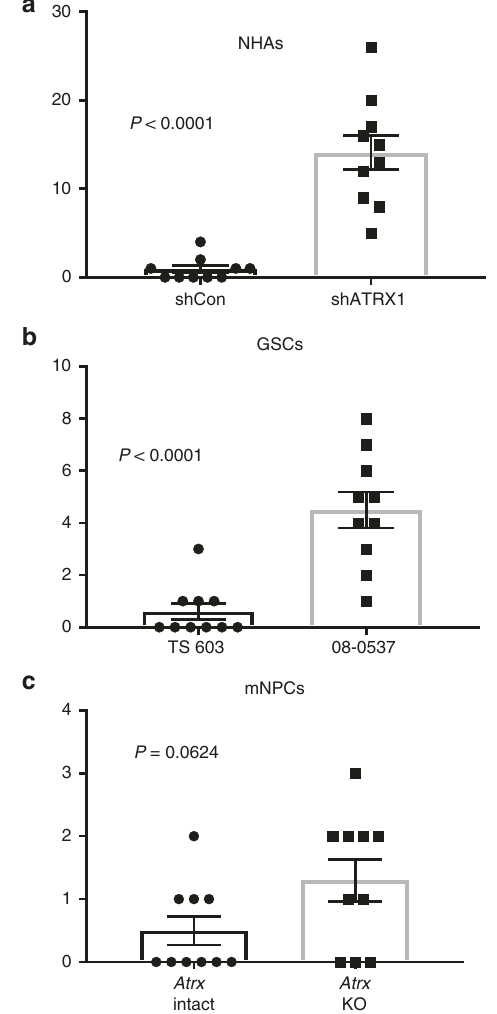
Fig. 3 ATRX de fi ciency induces chromosome breaks. a ATRX-de fi cient NHAs (shATRX1, passage 15) showed signi fi cantly increased chromosome breaks by cytogenetic analysis relative to ATRX-intact controls (shCon). b ATRX -mutant GSCs (08-0537) showed signi fi cantly increased chromosome breaks by cytogenetic analysis relative to ATRX wild-type GSCs (TS 603). c Quanti fi ed chromosome breaks in Atrx -intact and Atrx - KO mNPCs (also Tp53 -/-, passage 10). In all cases, 10 sets of chromosomes were quanti fi ed. Error bars re fl ect SEM; P values